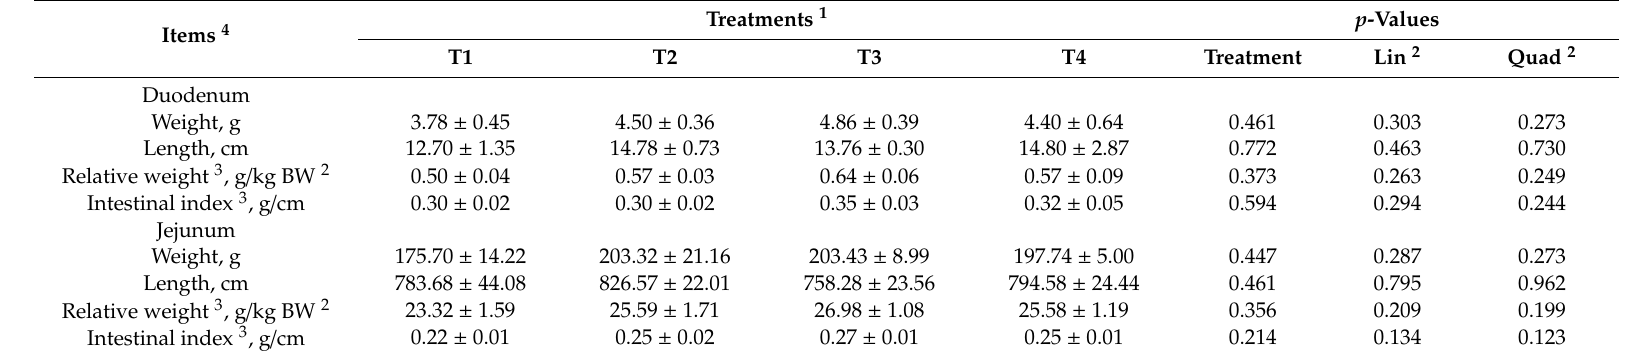
Table 7. E ff ects of the ratio of insoluble to soluble fiber in sow gestation diets on the intestinal development of weaned